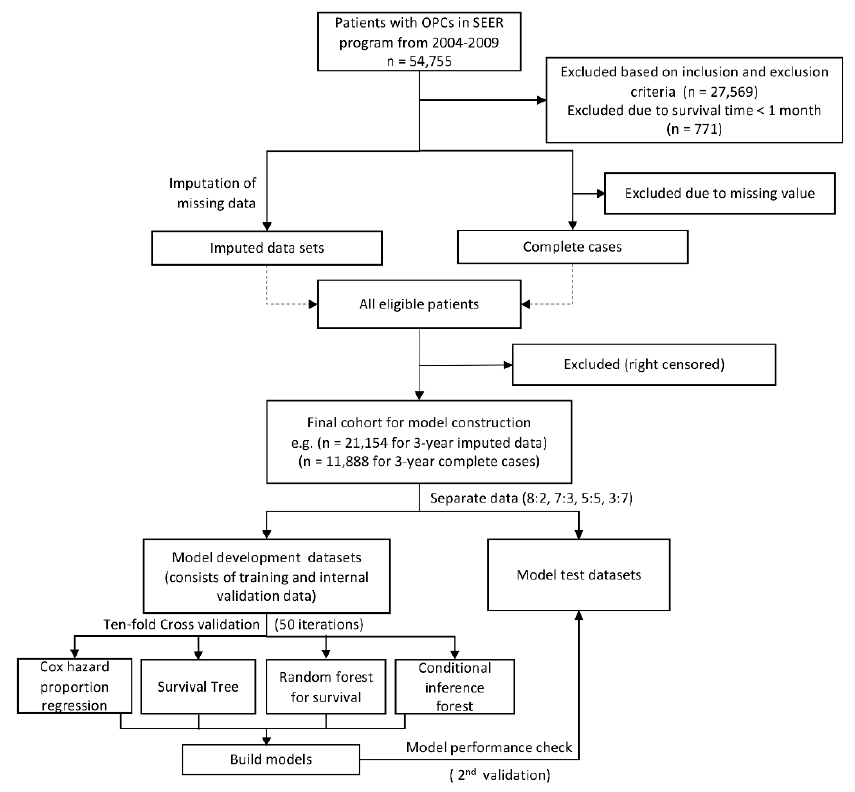
Figure 1. Flowchart of study design and patient selection.